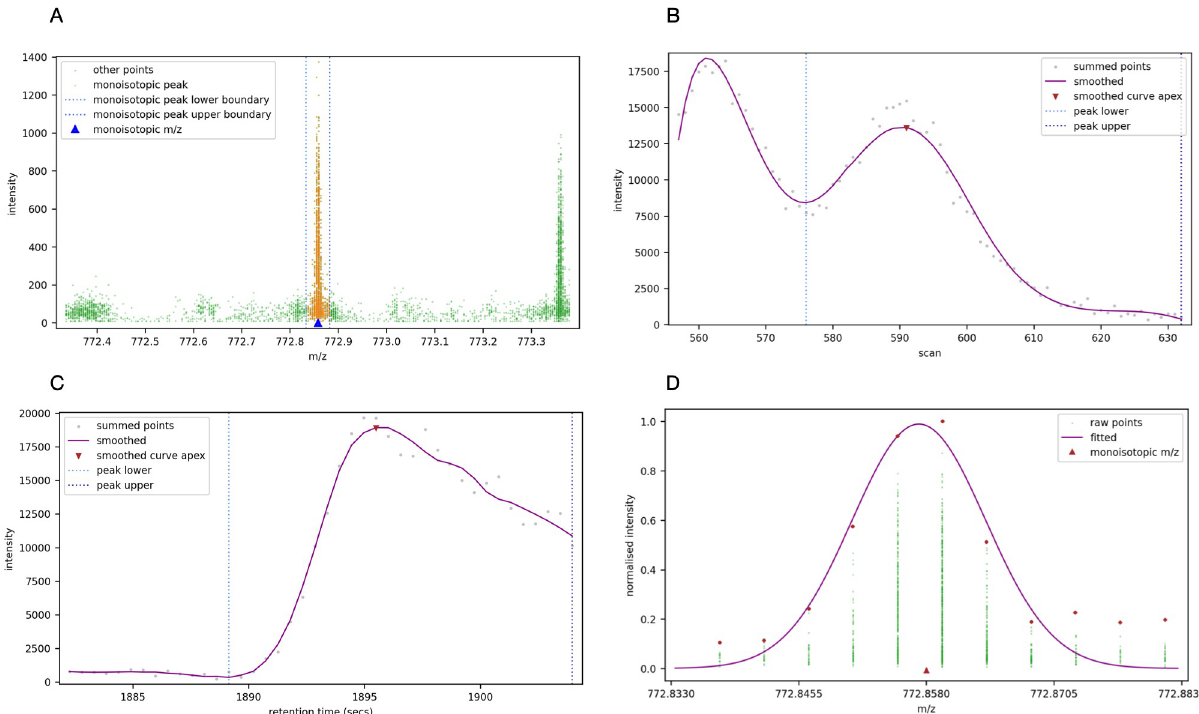
Fig 5. Resolution of a monoisotopic peak. (A) Zooming-in on the monoisotopic peak of proposed feature number 1. The dotted blue lines either side of the peak show the ± 3 σ limits at the peak’s m/z. (B) The points in the monoisotopic peak collapsed to the mobility dimension. There are two peaks quite close together in the mobility dimension. The marked peak is the closest to the centre of the fragmentation event. The blue dotted lines show the valleys that have been determined on each side of the highlighted peak. (C) The points in the monoisotopic peak collapsed to the retention time dimension. (D) A zoomed-in view of the feature’s monoisotopic peak in the m/z dimension.